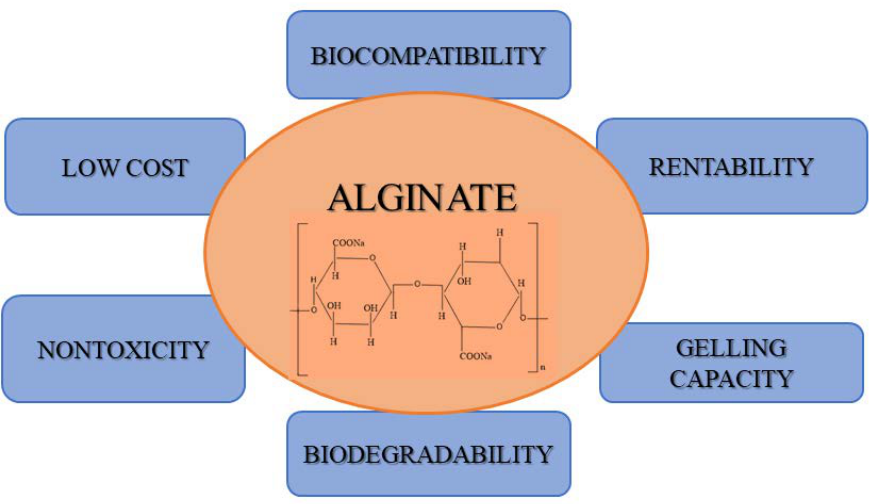
Figure 1. Alginate’s properties and its structure.